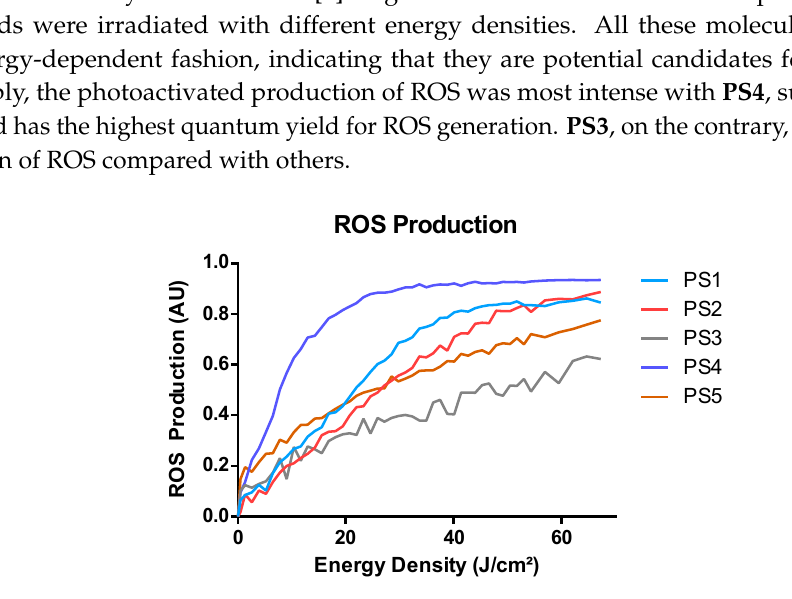
Figure 3. Photoactivated production of ROS by the candidate photosensitizers ( PS1 to PS5 , 40 µ M in water) expressed as arbitrary units (AU).